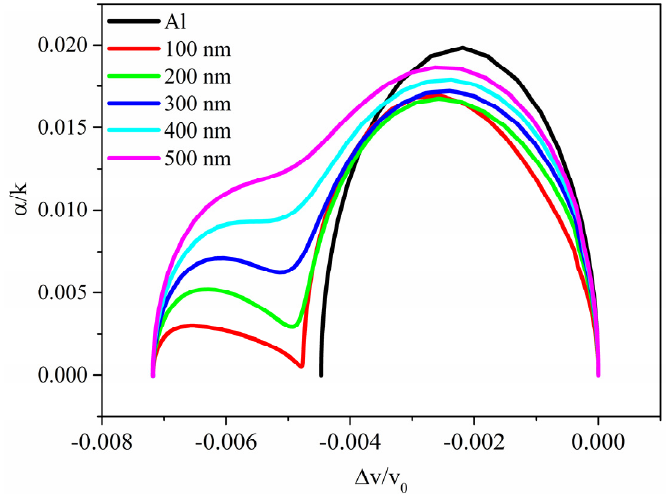
Figure 6. The α /k vs. ∆ v v 0 curves, with σ as the variable parameter for different values of δ sd (which varies in the range from 100 to 500 nm); the black curve represents the case of ZnO half-space covered by a thin Al layer.